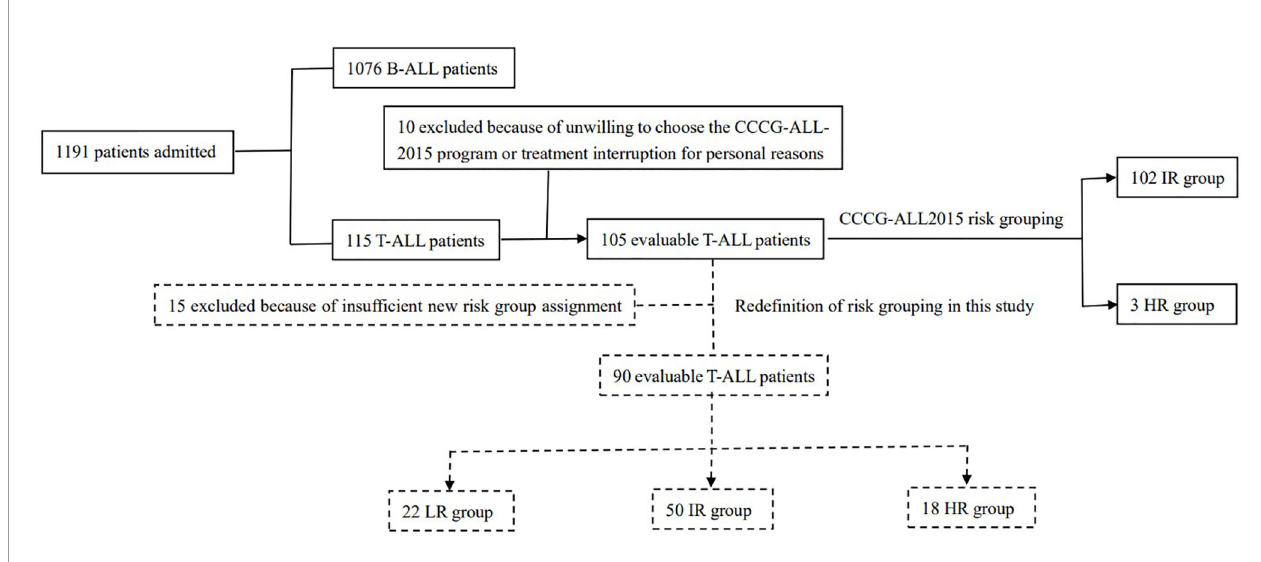
FIGURE 1 | The composition and distribution of